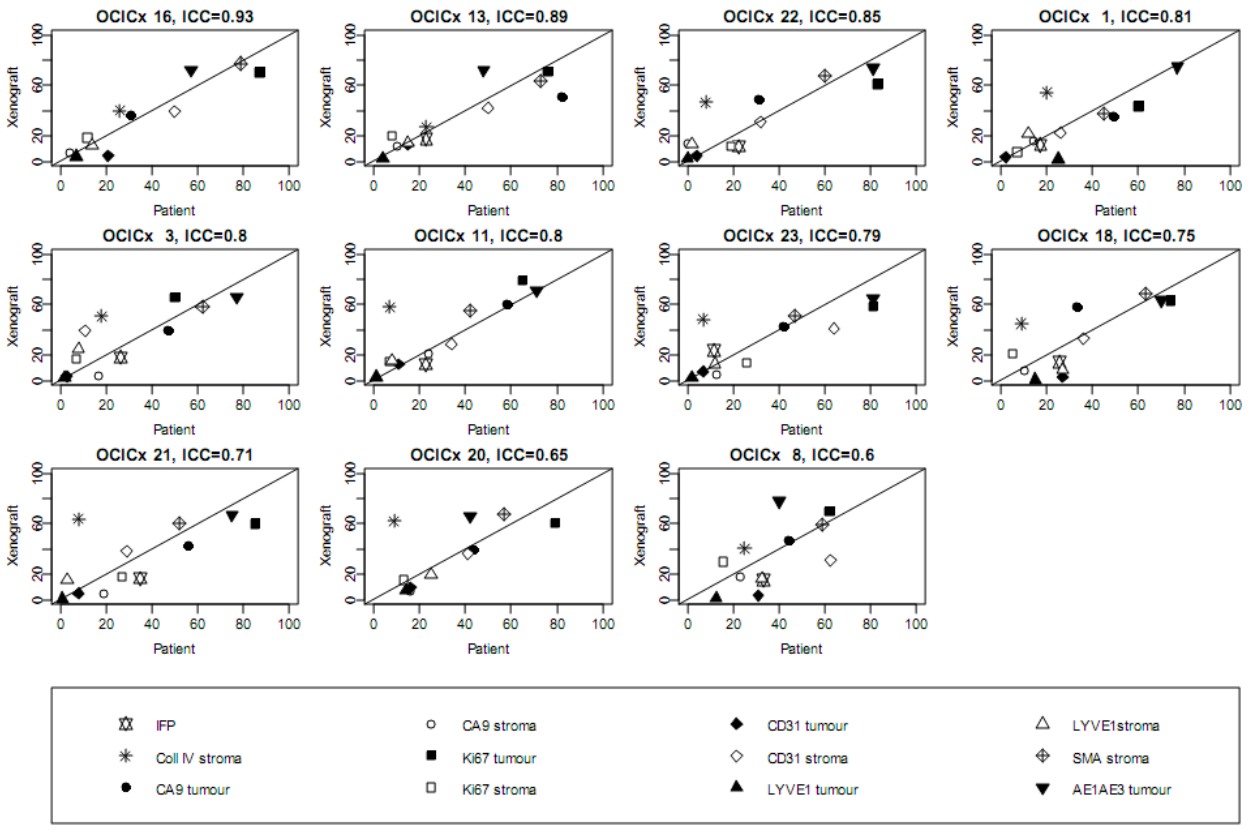
biopsy. Plots for IFP and tumor and stroma measures for hypoxia, blood and lymphatic vessels, proliferation and smooth muscle actin. Lines plotted are the (0,1) line of perfect concordance. Collagen IV is shown in the full data set in ( A ) and excluded as an outlier in ( B ). Values are listed in Supplementary Table